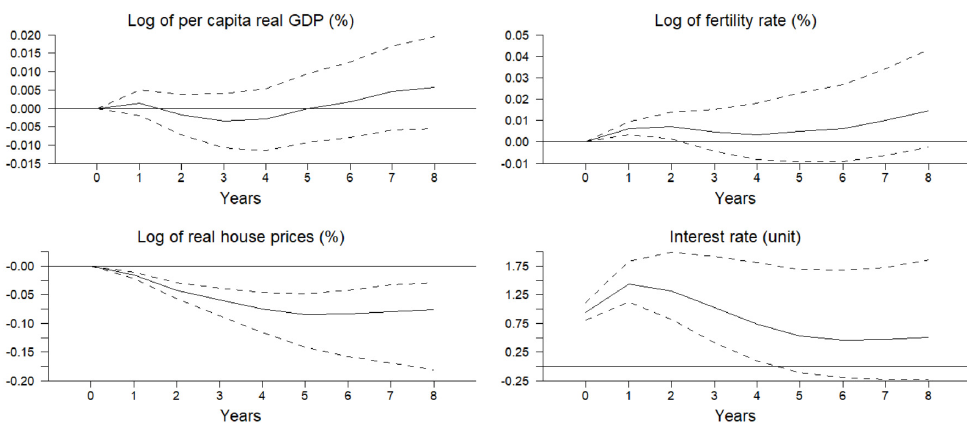
Figure 9. Responses to an interest rate shock in the baseline structural VAR with the homeownership rate as an exogenous variable in the model .